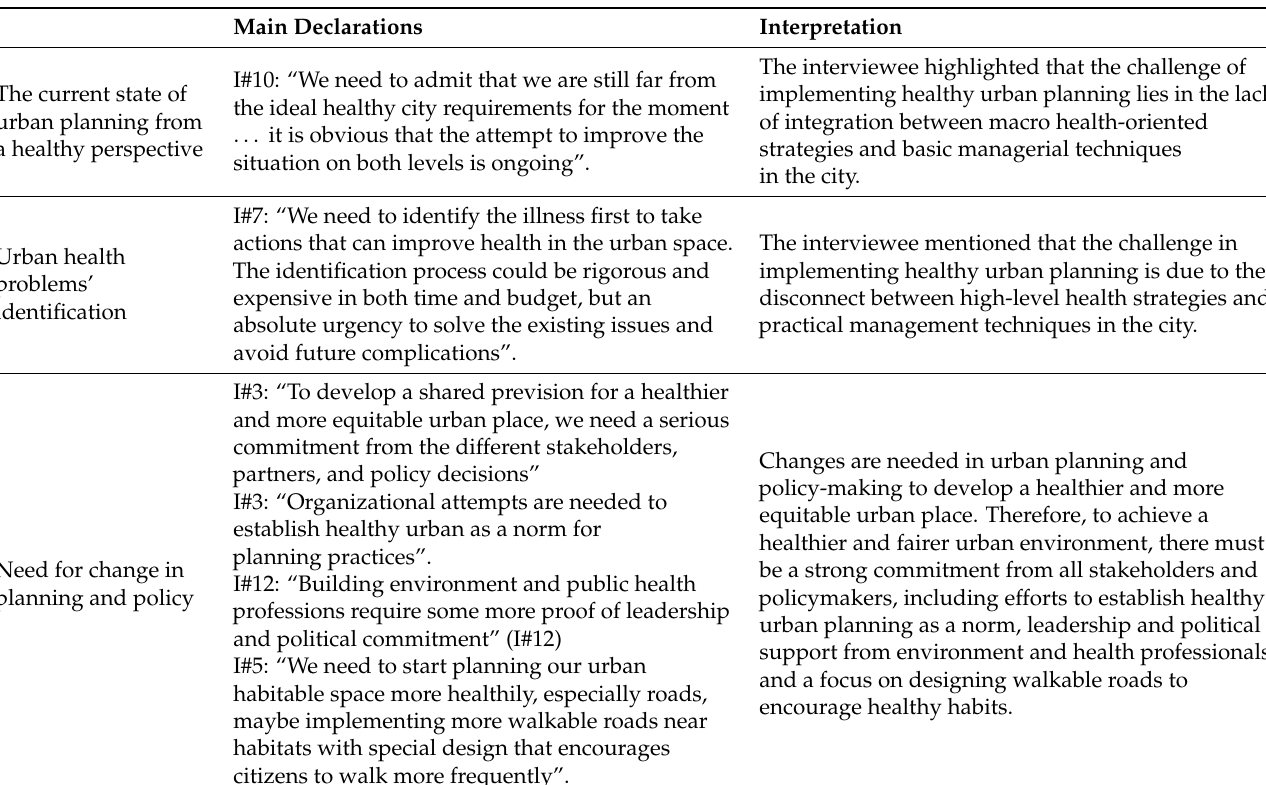
Table 3. Theme 3: integrating health concepts in the urban planning process—results and interpreta- tion